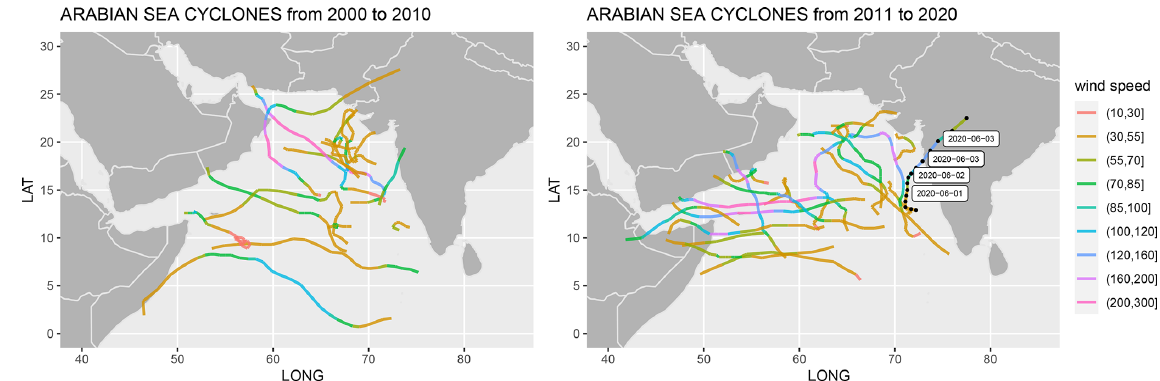
Figure 14. Cyclone tracks and their wind speeds during 2000–2010 (left) and 2011–2022 (right). The cyclone Nisagra is marked by its propagation dates.